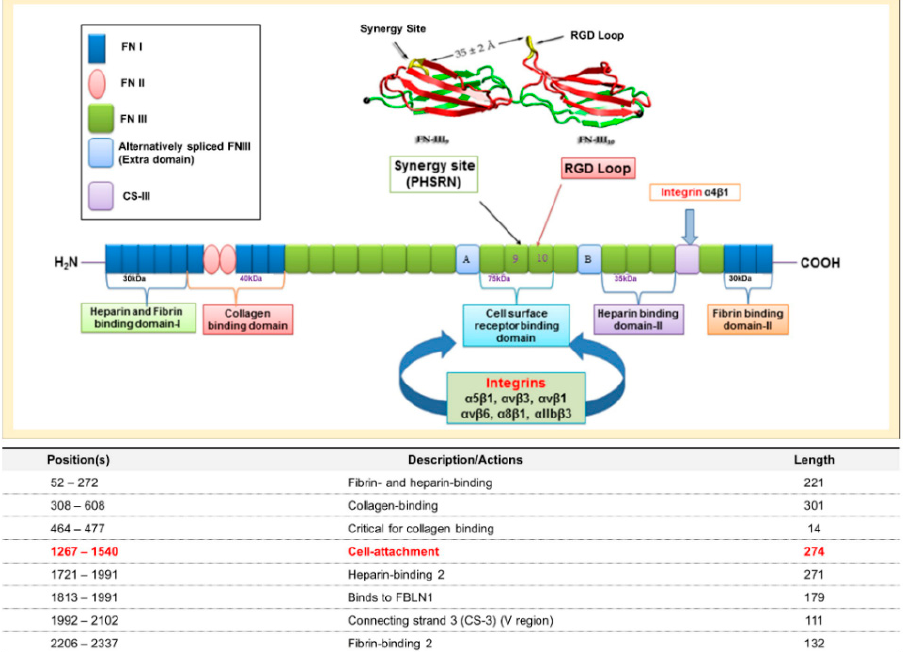
Figure 1. Structure and binding domains of fibronectin (FN). FN consists of three types of repeats FNI, FNII, and FNIII. These sets of repeats possess several binding domains viz. heparin, fibrin, collagen, and cell surface receptor-binding domains. Extra domains A and B are formed in alternatively spliced FNIII. CS-III is another alternatively spliced section and a binding site for integrin α 4 β 1. The cell- attachment domain (from position 1267–1540) is the binding site for several integrins (e.g., α 5 β 1, α v β 3, and α IIb β 3). The RGD loop and synergy site (PHSRN) is a key binding site for several integrins.